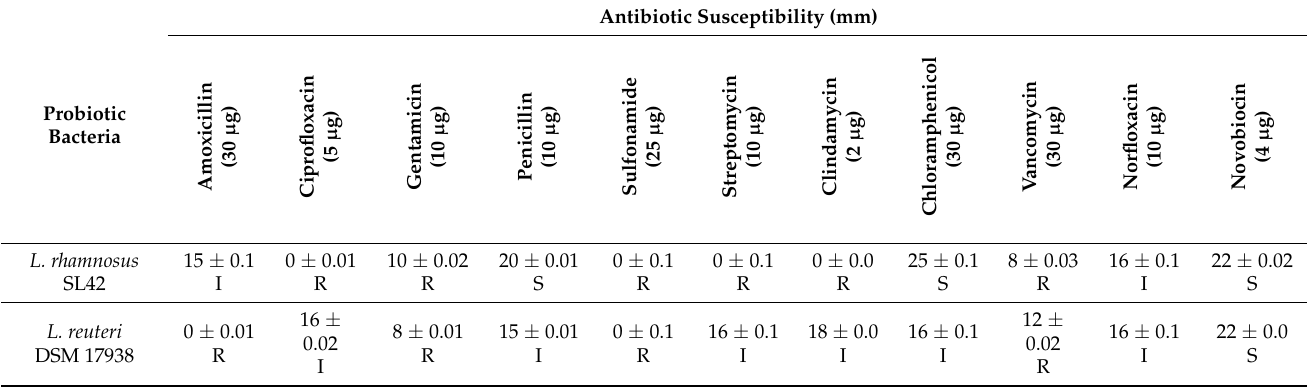
Table 3. Antibiotic susceptibility * of probiotic